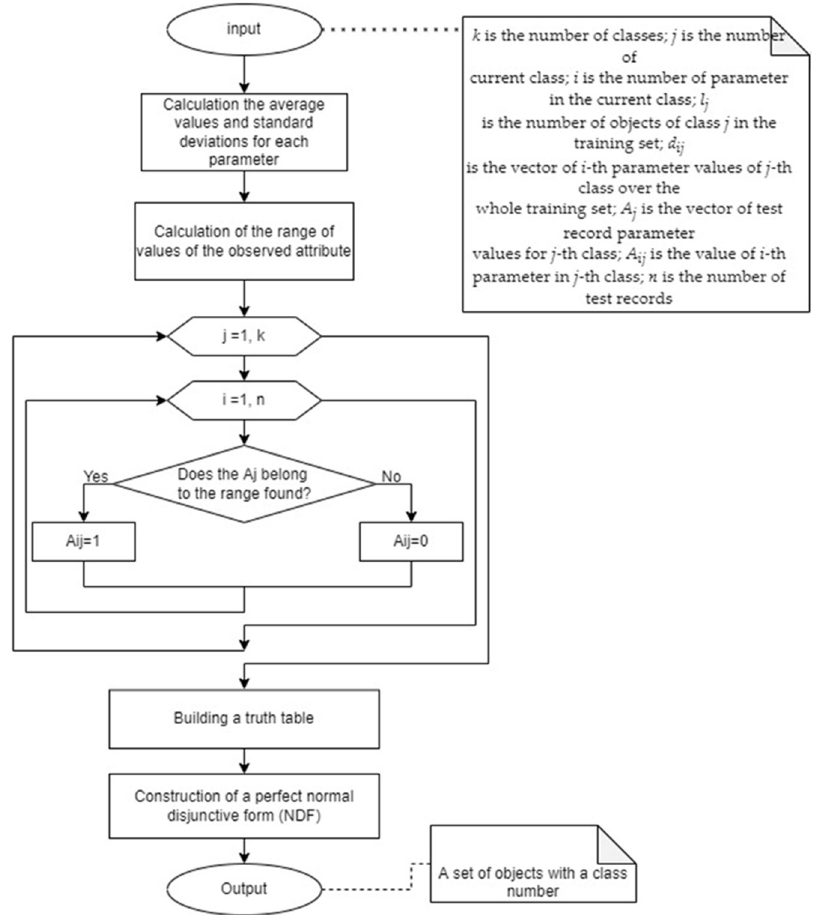
Figure 2. Flowchart of the method of classification based on boolean logic (with improvements). Improvement of method.